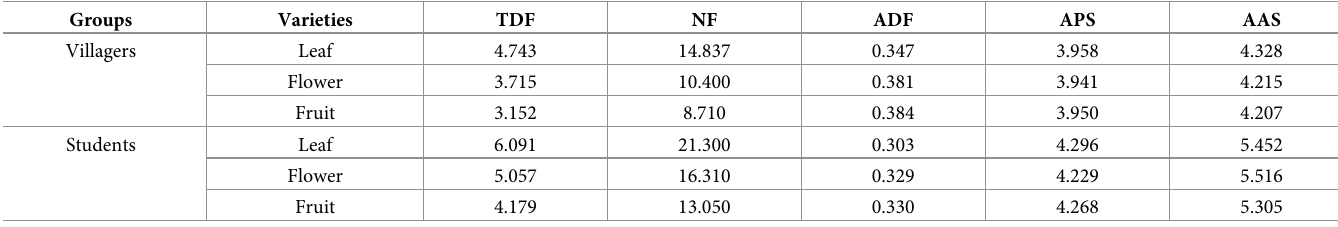
Table 3. Mean results of eye movement indicators of two populations on different plant organs.